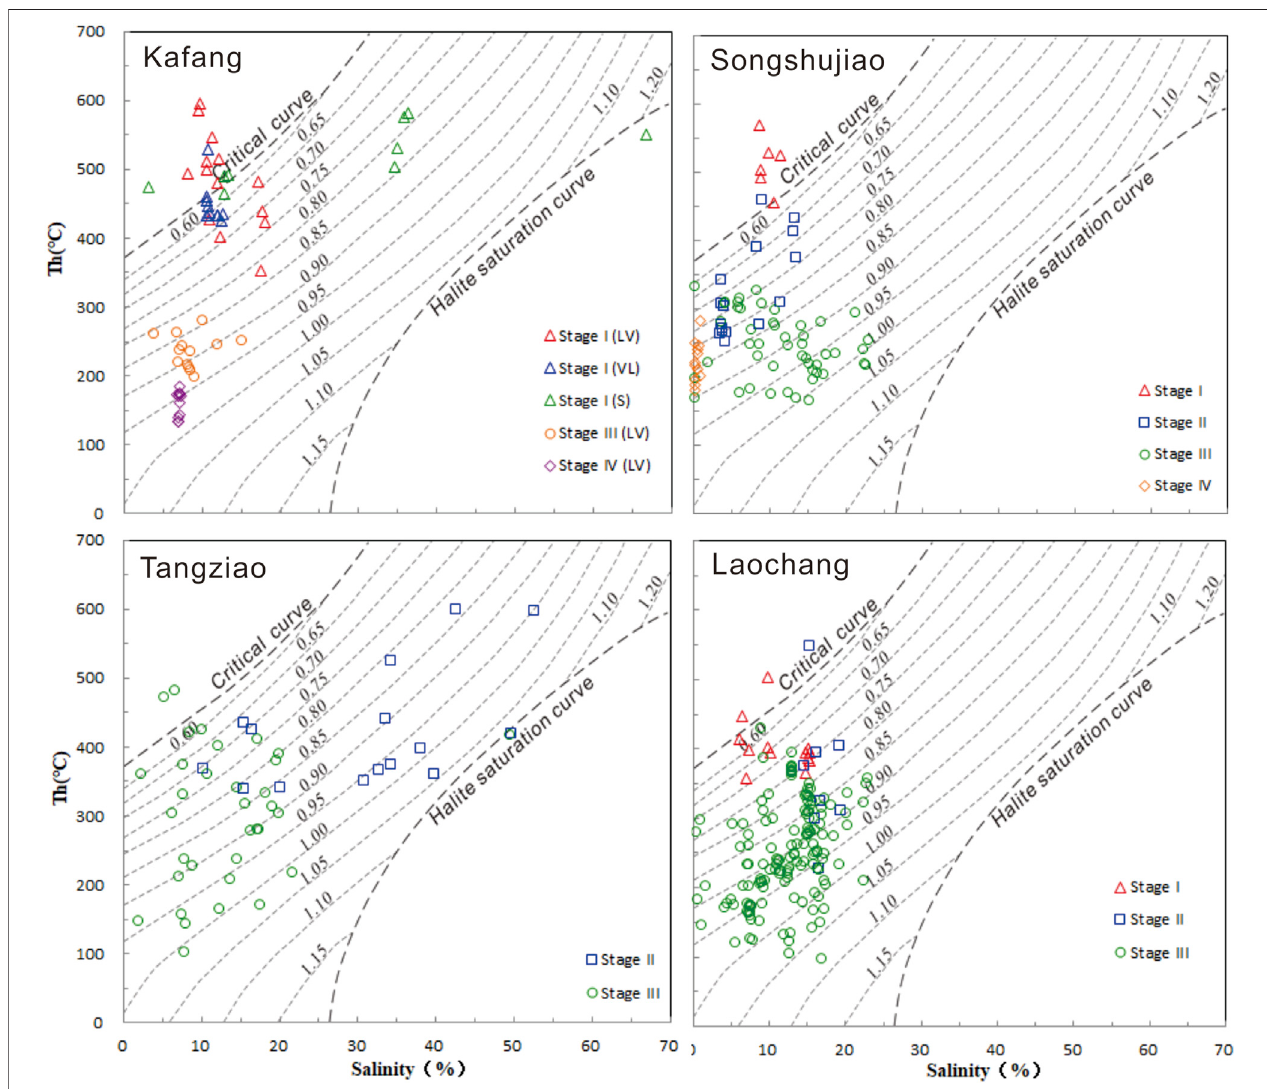
FIGURE 7 | Homogenization temperature – salinity – density diagram of fl uid inclusions showing the path of evolution of the fl uid of the Gejiu Sn – Cu polymetallic ore district(H 2 O – NaClsystem),includingtheKafang,Laochang,Tangziao,andSongshujiaooredeposits(compiledfollowingBakker,2018).StagesI,II,III,andIVrepresent the different stages of mineralization. L, V, and S represent types of fl uid inclusion.